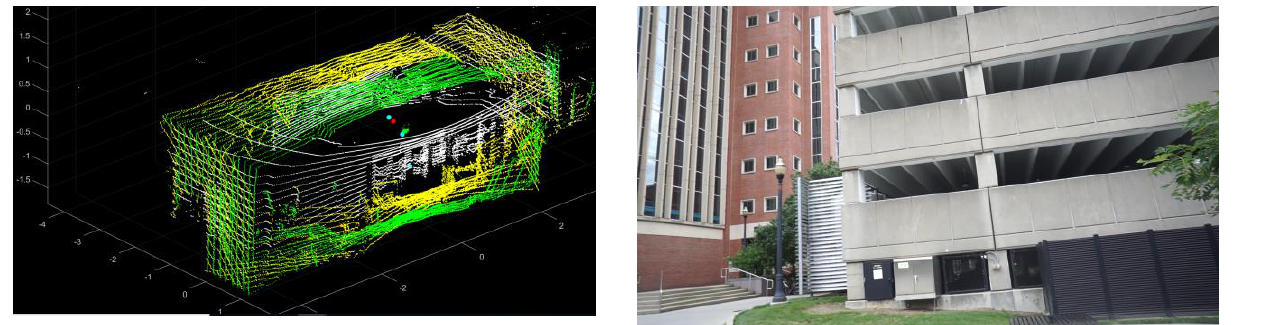
Figure 4. Lever-arm and boresight calibration between the laser Figure 6. Outside view from Sony_1 scanners. White: points coming from horizontal scanner VELO_1; green: vertical VELO_3; yellow: 45º scanner VELO_2; cyan: positions of laser scanners; red: position of IMU Our system can operate in outdoor scene as well, what is shown Figure 5. Point cloud captured in outdoor environment (single frames from VeloView): horizontal scanner VELO_1 (top), vertical scanner VELO_3 (middle), 45º scanner VELO_2 (bottom).. As we can see, the best view/observation of the scene can be delivered by the horizontal scanner. The other two scanners are mainly useful for achieving higher point density and capturing higher facades. In Figure 6. Outside view from Sony_1also a camera view in an outdoor scene is presented.